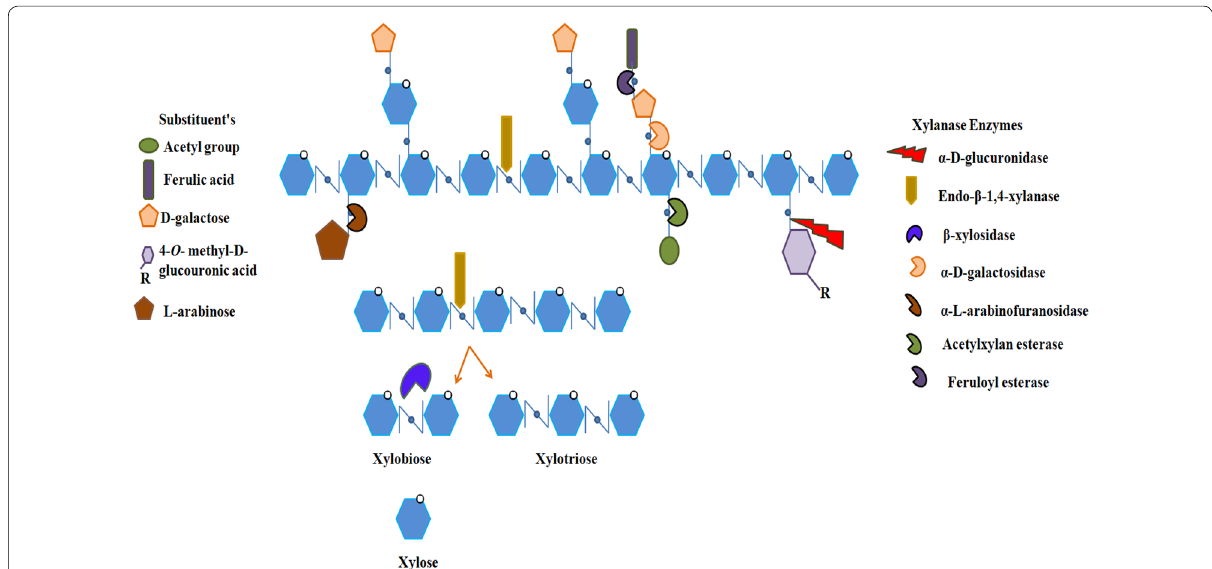
Fig. 1 Structure of xylan showing bonds which are attacked by specific xylanolytic enzyme for complete hydrolysis of xylan to its constituents (Adapted from Beg et al. 2001, Lange